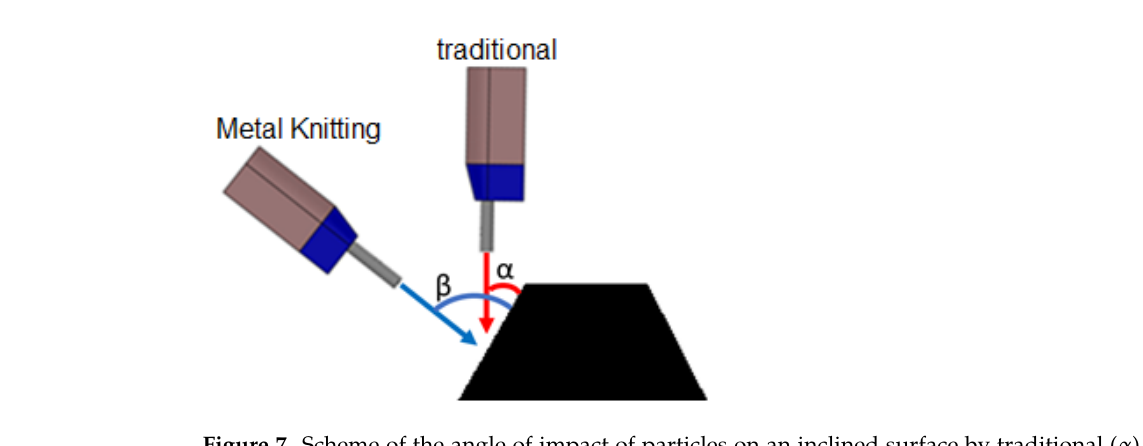
Figure 7. Scheme of the angle of impact of particles on an inclined surface by traditional ( α ) and Metal Knitting ( β ) strategies.